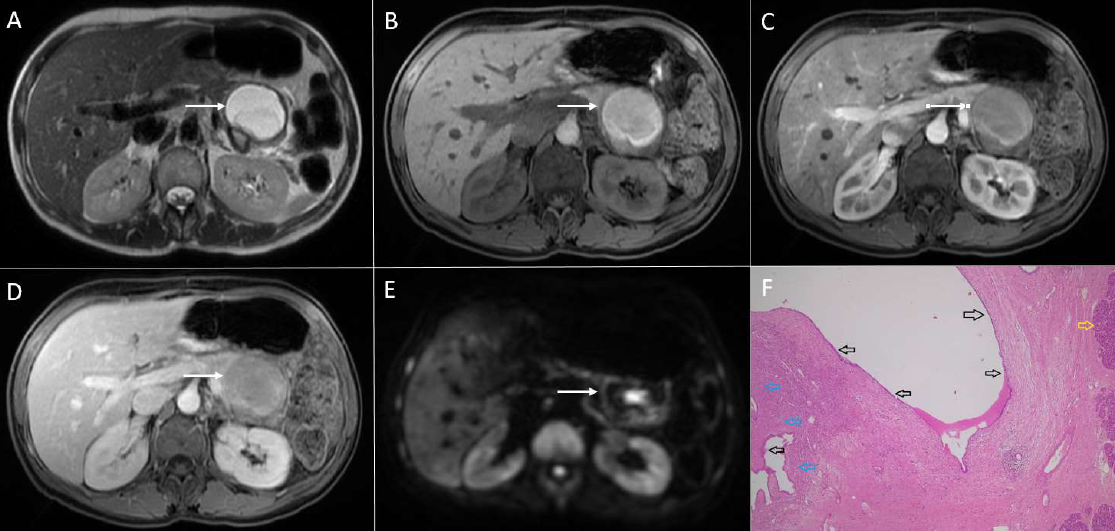
Figure 9. Non-mucinous cystadenoma of the pancreas in 42-year-old woman. T2-weighted image ( A ) shows septated cystic lesion ( arrow ) in the pancreatic tail. On T1-weighted FS image ( B ), the lesion ( arrow ) is hyperintense indicating hemorrhagic content. The lesion remains hyperintense in arterial ( C ) and portal-venous phase ( D ) due to high inner signal intensity on native T1-weghted image but without detectable vascularization on subtracted images (not shown). On DWI ( E ), the tumor displays central area of restricted diffusion. Hematoxylin and eosin (H&E) staining ( F ) showed non-mucinous cystadenoma lined with bilio-pancreatic epithelium ( black arrows ), and ovarian-like stroma in the wall of the cyst ( blue arrows ). Normal pancreatic parenchyma is also seen ( yellow arrow ); original magnification ×